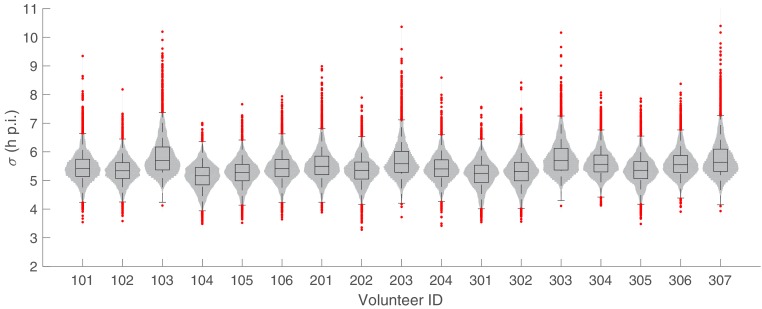
The marginal posterior distributions of the individual parameter of σ (Standard deviation of the initial parasite age distribution) for all 17 volunteers.The violin plots (gray area) show the distributions of 5000 posterior samples. Box plots show the 25%, 50% (median) and 75% quantiles with outliers indicated by red dots. Relevant details of the individual parameter are provided in the Materials and methods in the main text.